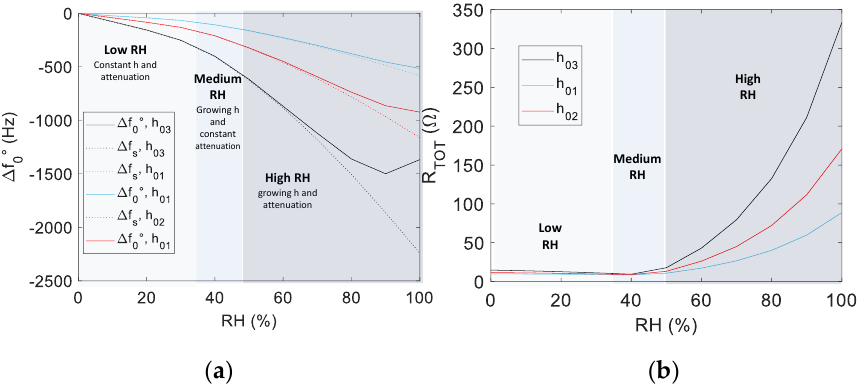
Figure 6. Simulated responses of a functionalized QCM as a function of the RH level (hence on the film density), with initial film 1000 kg/m 3 and considering three different initial film thicknesses (h 01 = 10 nm, h 02 = 20 nm, h 03 = 37.7 nm). ( a ) A frequency shift of the oscillator frequency (f 0 ◦ ) with respect to the frequency measured in dry air; ( b ) motional resistance. The simulations account for the effect of a thickness increasing proportionally to RH level for RH higher than 27%, and finally for both thickness and attenuation increasing proportionally to the density for RH levels higher than